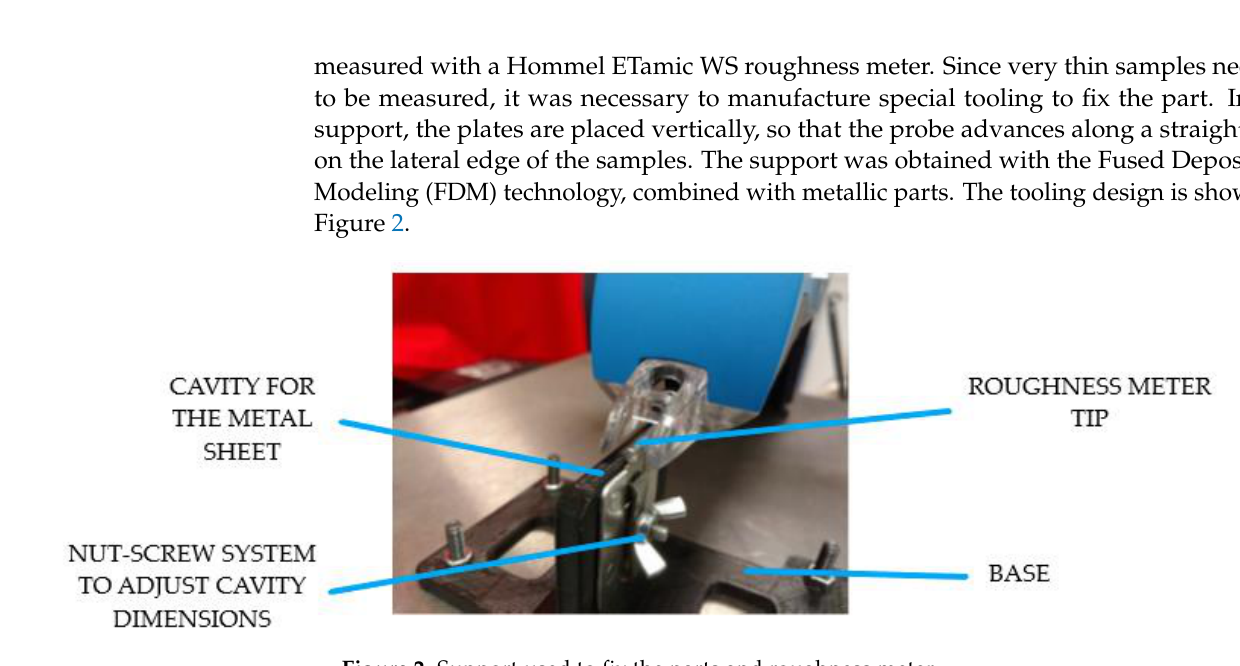
Figure 2. Support used to fix the parts and roughness meter.